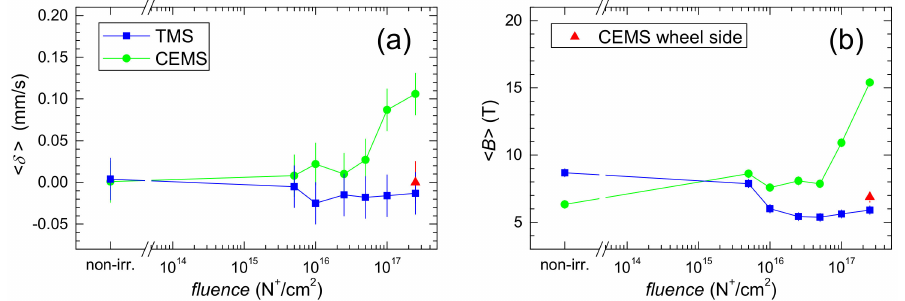
Figure 4. Parameters derived from transmission (TMS, blue) and CEMS (green) Mössbauer spectra of Fe 76 Mo 8 Cu 1 B 15 irradiated by 130 keV N + ions plotted against the ion fluence: ( a ) Average isomer shift, (cid:104) δ (cid:105) ; ( b ) average hyperfine magnetic field, (cid:104) B (cid:105) . Red triangles correspond to the CEMS spectrum taken from the wheel side of the ribbons. Solid lines are only guides for the eye.